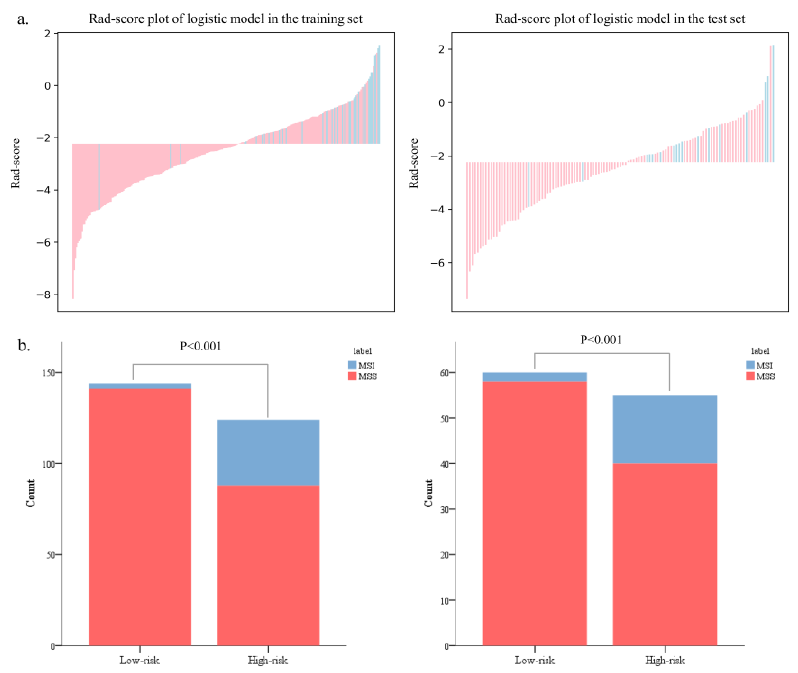
Figure 7. The bar charts of rad-scores in the training and test sets ( a ). The probability of MSI in the high-risk group was significantly higher than that in the low-risk group in both the training and test sets ( b